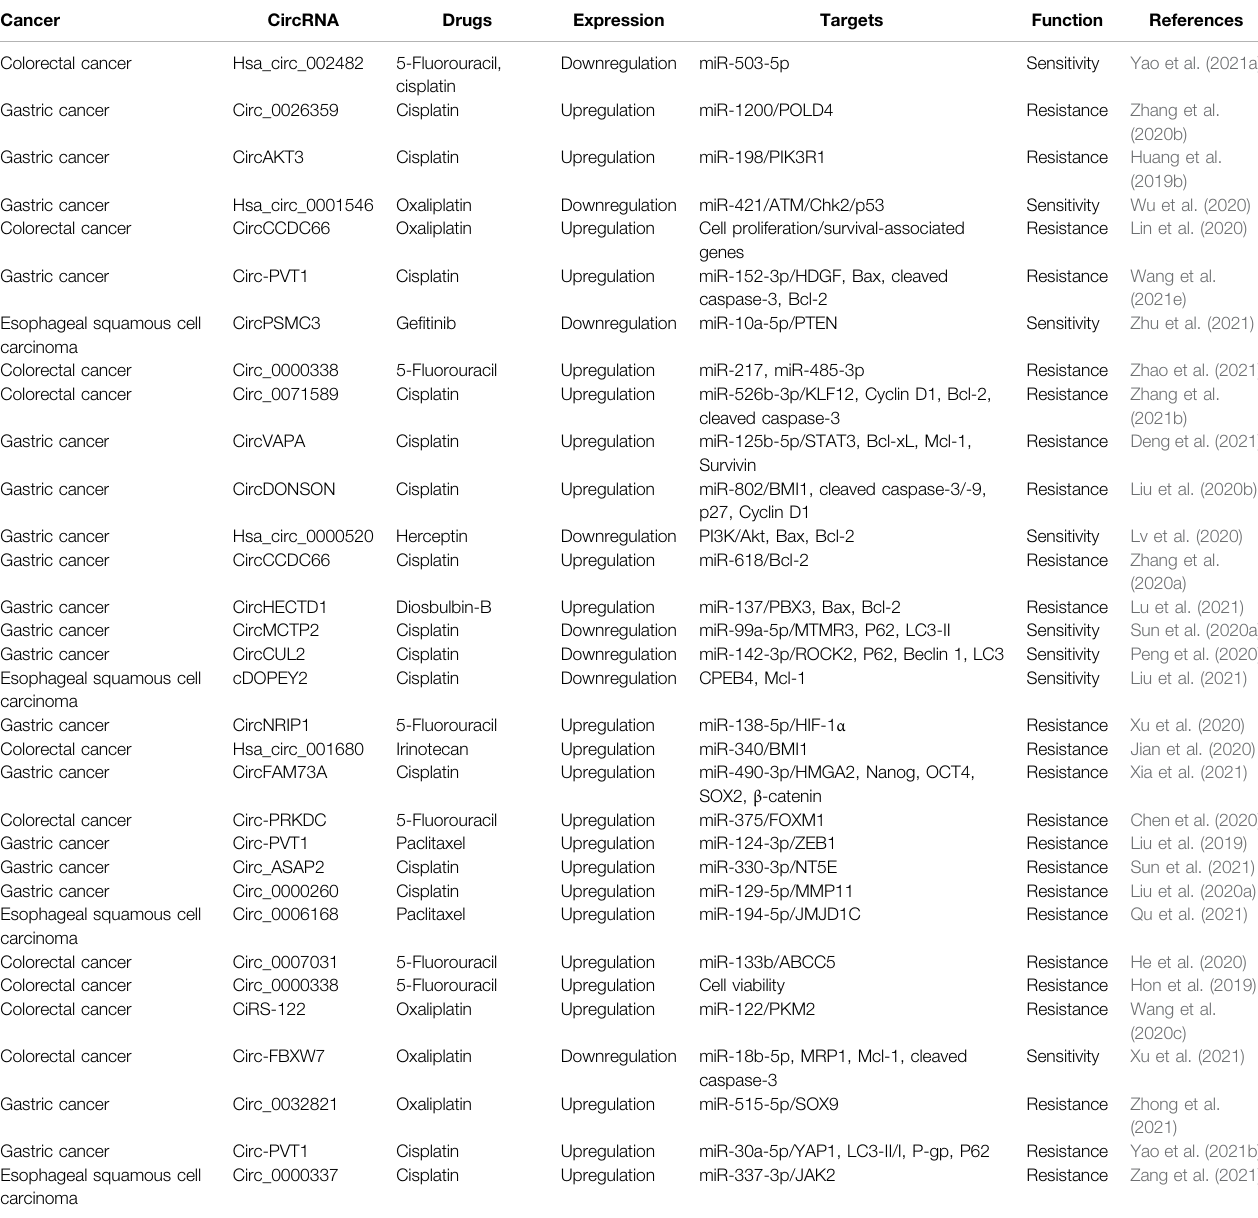
TABLE 1 | Chemoresistance-relevant circRNAs in gastrointestinal